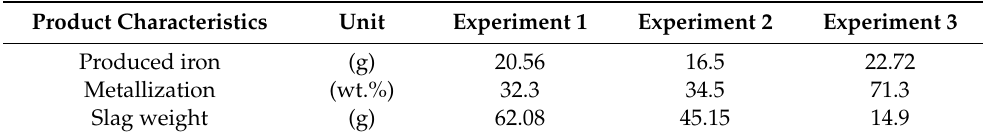
Table 9. Produced iron and slag for operations in 1387 s.